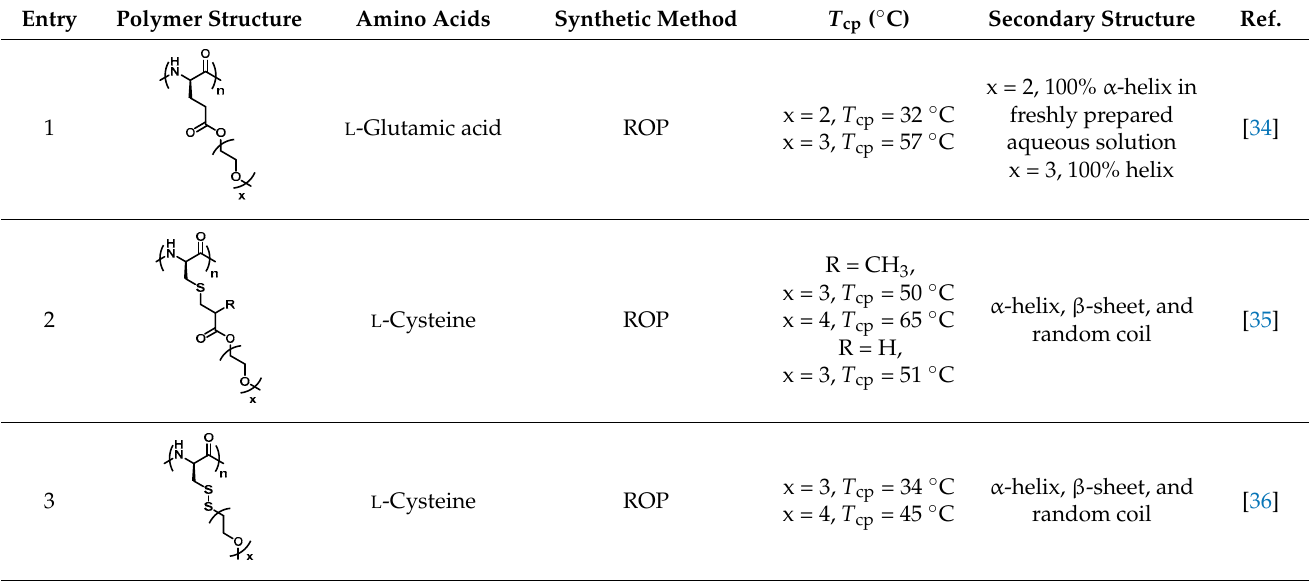
Table 1. Summary of thermoresponsive OEGylated poly(amino acid)s.